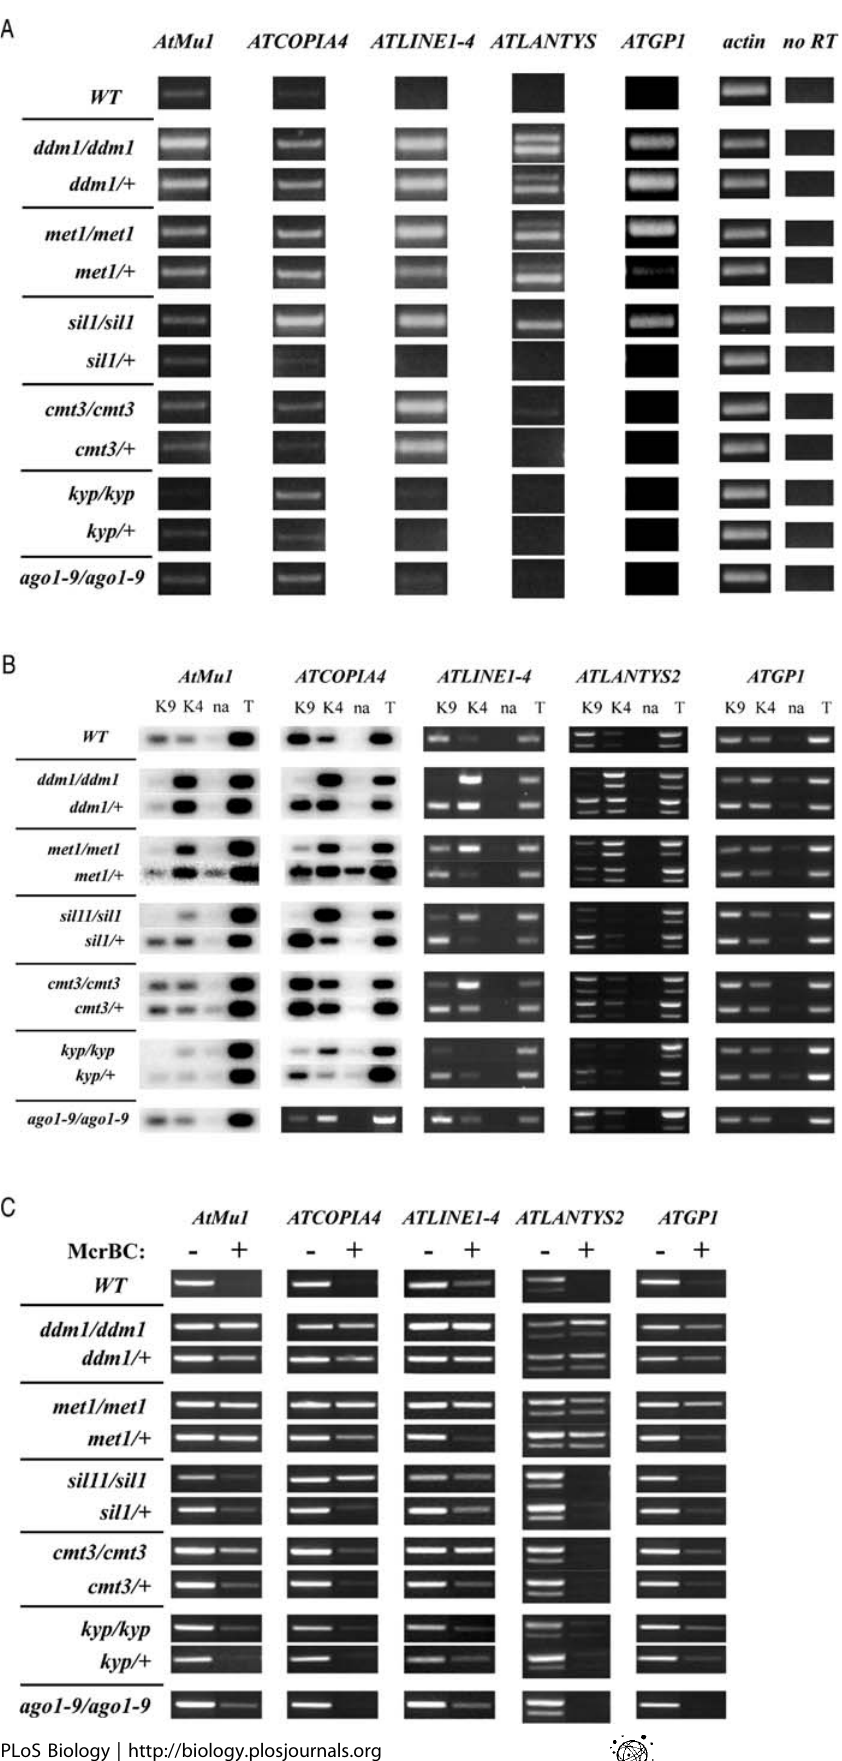
Figure 2. Inheritance of Transposon Mod- ification Reverse-transcribed cDNA (A), ChIP (B), and McrBC-digested genomic DNA (C) were amplified by PCR using primers from five retroelements and one DNA transposon in mutant (m/m) and back- crossed plants (m/ þ ). Primers corre- sponded to transcribed ORFs for each element except for AtMu1 ChIP, which was done on the terminal inverted repeat (TIR). For ATLANTYS2 , the larger product is ATLANTYS2-1 and smaller product is ATLANTYS2-2 . Input RNA was normalized for each genotype using actin